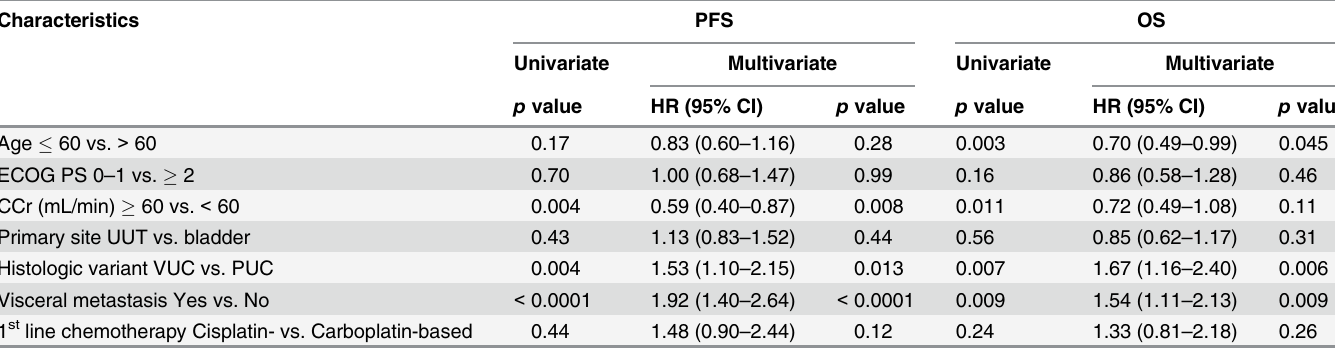
Table 3. Univariate and multivariate analyses of PFS and